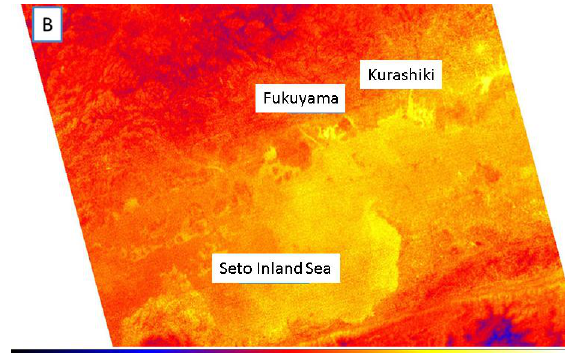
Figure 8. Zoom of the region B from Figure 6.